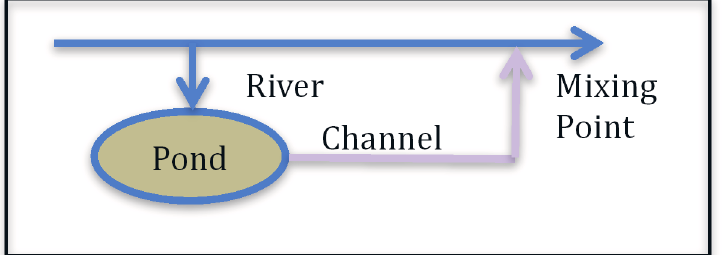
Figure 1. Diagram of a representative problem (Chapra, Problem 10.3) where mass passes from a pond to a channel and is conservatively mixed into a